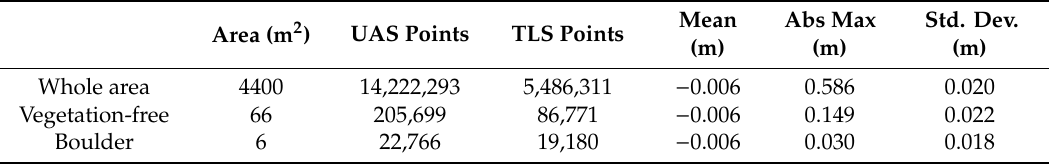
Table 5. TLS vs. UAS—results.